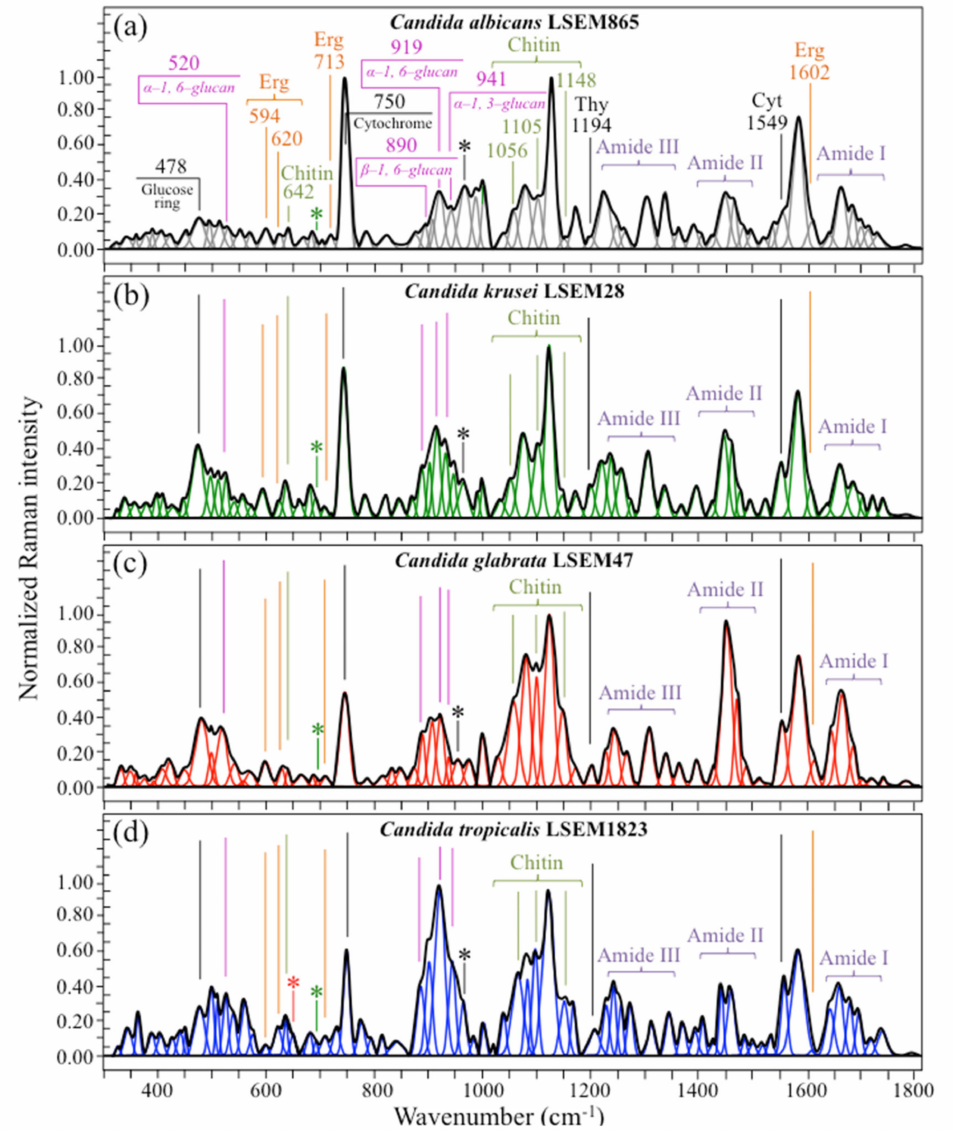
Figure 2. Raman spectra of ( a ) C. albicans , ( b ) C. krusei , ( c ) C. glabrata , and ( d ) C. tropicalis . Spectra are averages of 20 spectra collected on each sample with a 20 × optical lens and with a spectral resolution better than 1 cm − 1 . The meaning of the asterisk marks is given in the main